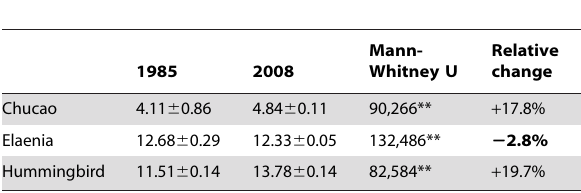
Table 4. Estimated density (individuals per hectare, average 6 standard error) for three forest-bird species across all forest patches present in the study area (1214.75 km 2 , see